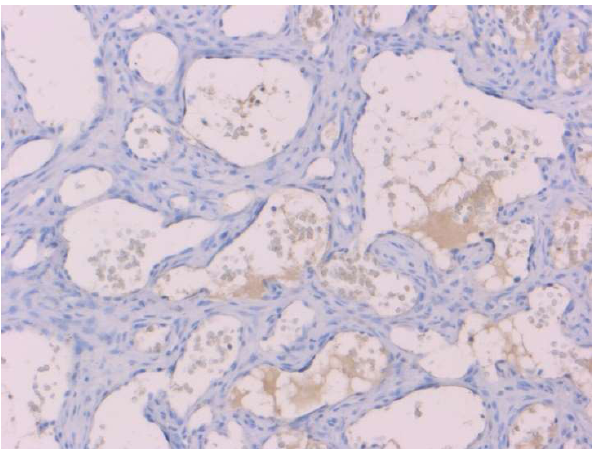
Figure 2. Kidney of a dog after PIVKA-II immunostaining. Positive cytoplasmic immunoreactivity within the renal tubules and Bowman’s capsule. PIVKA-II immunohistochemistry, Mayer’s hematoxylin counterstain, and 20× objectives. When haemangiosarcoma was diagnosed, immunohistochemistry against PIVKA-II was carried out with negative results for all of the cases (Figure 3).